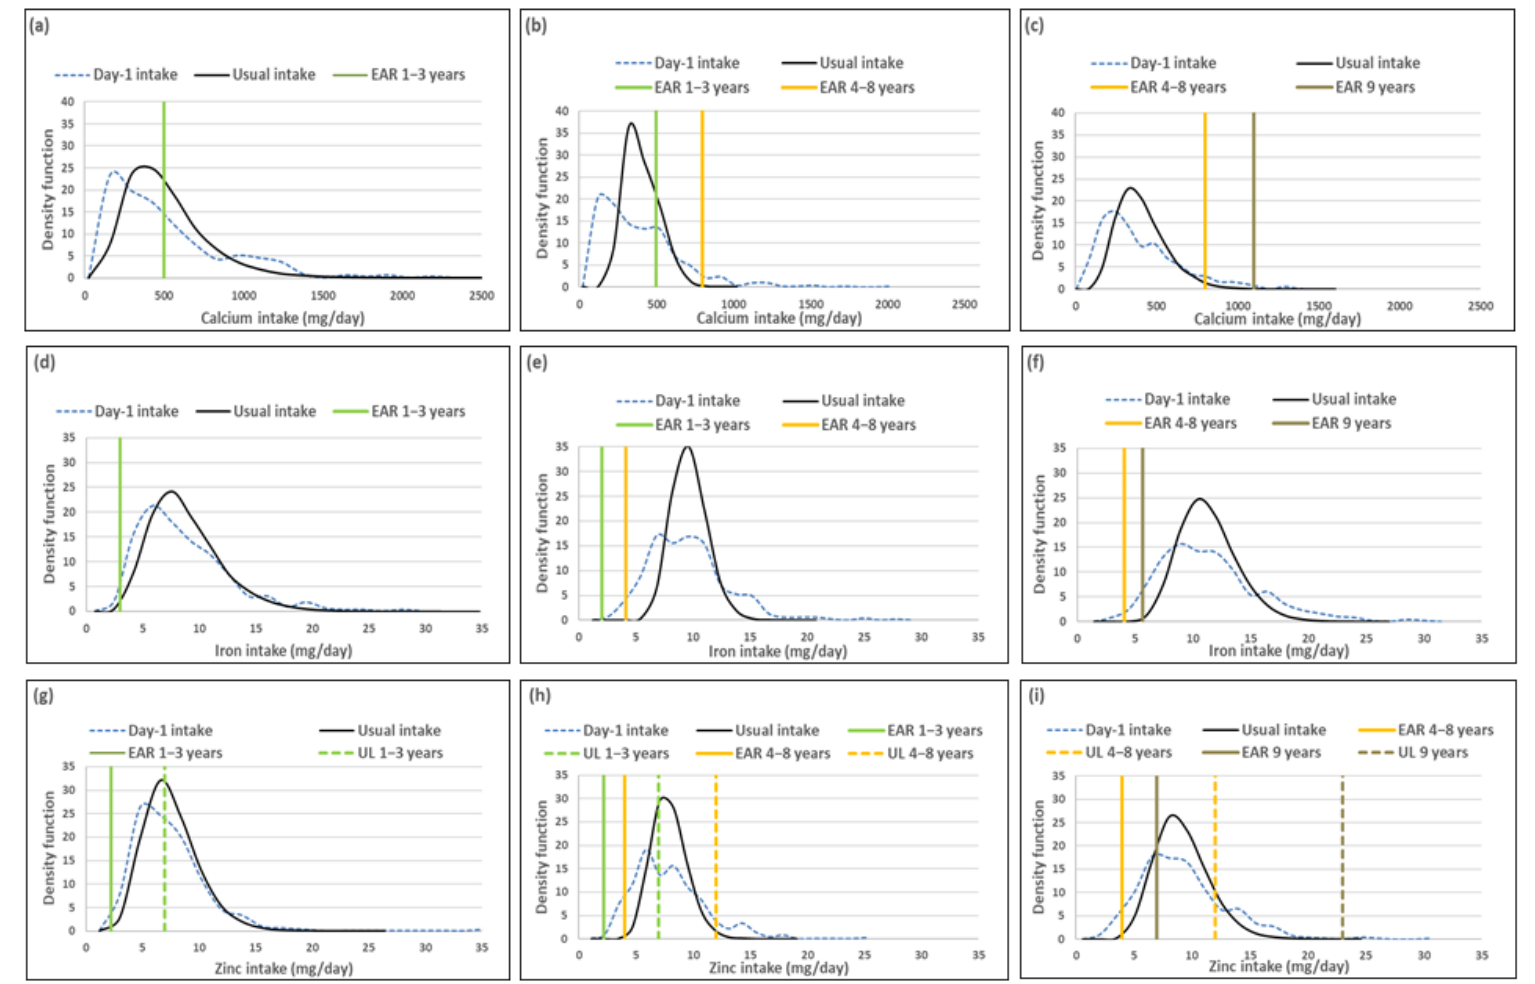
Figure 1. Distributions of the simulated, back-transformed values (usual intake) and the distribution of Day-1 intakes within the context of DRI-values of calcium, iron and zinc, by age group. ( a ): Age 1 − <3 years: Calcium intake; ( b ): Age 3 − <6 years: Calcium intake; ( c ): Age 6 − <10 years: Calcium in- take; ( d ): Age 1 − <3 years: Iron intake; ( e ): Age 3 − <6 years: Iron intake; ( f ): Age 6 − <10 years: